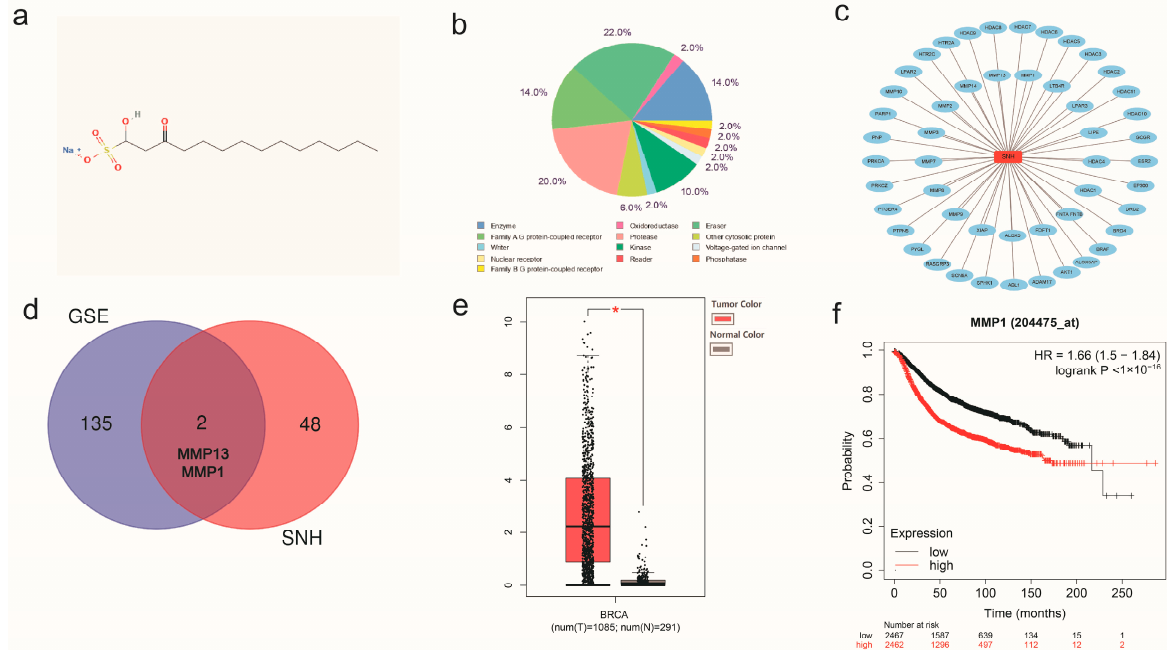
Figure 2. Network pharmacology analysis of SNH. ( a ) The chemical structural formula of SNH. ( b ) Category statistics of potential targets of SNH. ( c ) The potential targets of SNH were predicted using SwissTargetPrediction. ( d ) The common target genes of SNH and these two profiles (GSE139038 and GSE109169). ( e ) Differential expression of MMP1 in breast cancer. ( f ) Relationship between MMP1 and prognosis in breast cancer. All results are expressed as mean ± SD of three independent experiments. * p < 0.05.